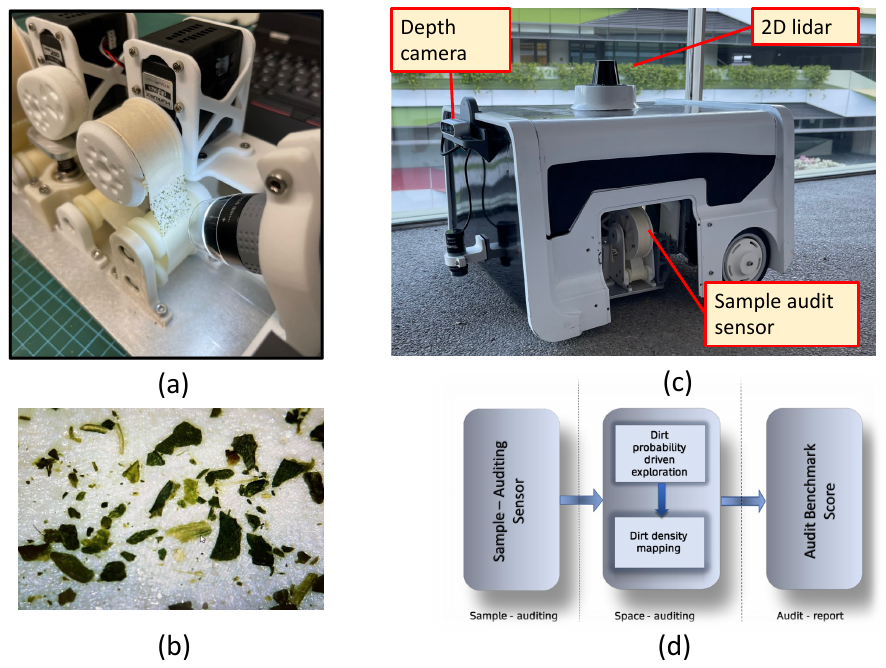
Figure 1. The dust extracted by the sample audit sensor ( a ), the dust particles viewed by the microscope of the sample audit sensor ( b ), the BELUGA audit robot equipped with sample audit sensor ( c ), and the overview of robot-aided cleaning auditing framework [19] ( d